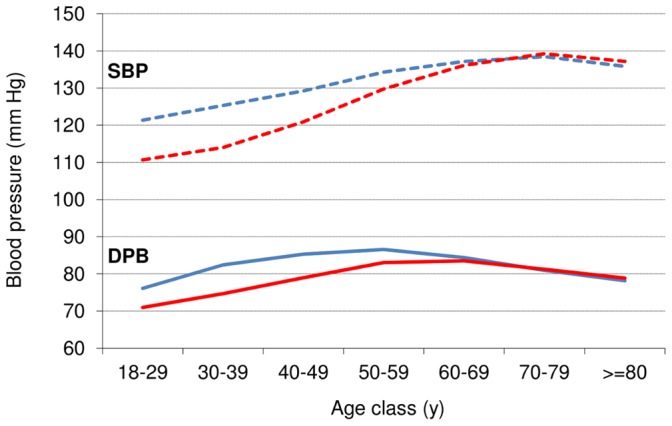
Mean systolic and diastolic blood pressure by age and sex in the overall sample, Ogliastra, 2002–2008.Men are represented by blue lines.